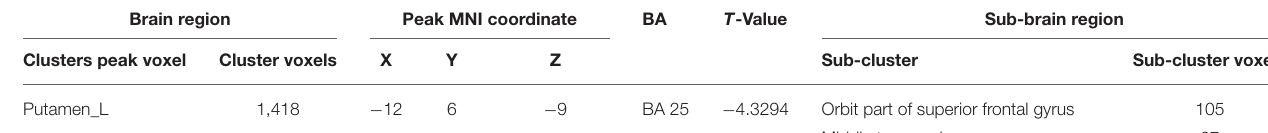
TABLE 2 | Difference area of two sample t -test under the condition of subtracting neutral picture from negative emotion picture between PMS group and HC group in BOLD-fMRI. Brain